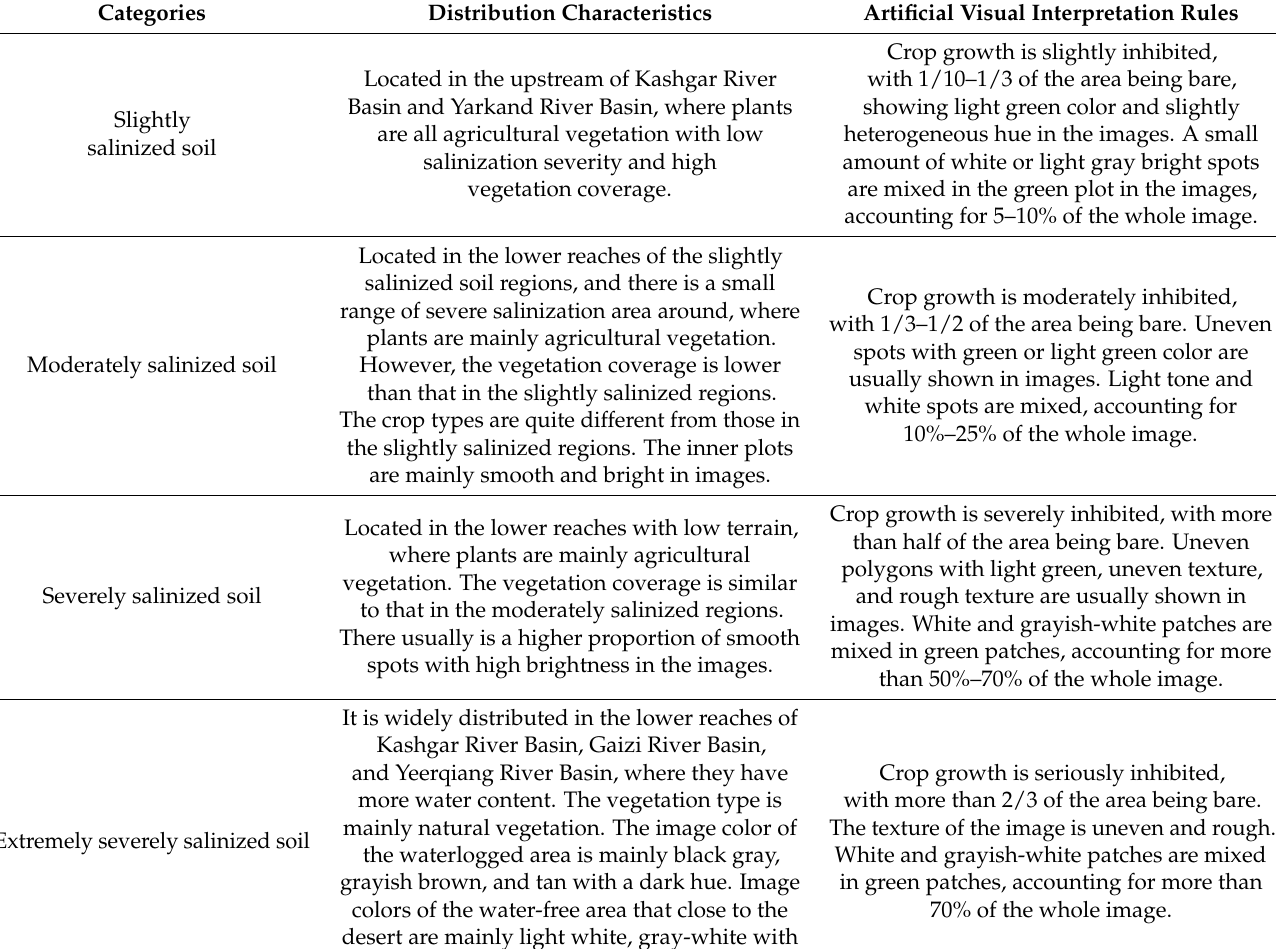
Table 2. Visual interpretation rules for the soil salinization classification based on Landsat